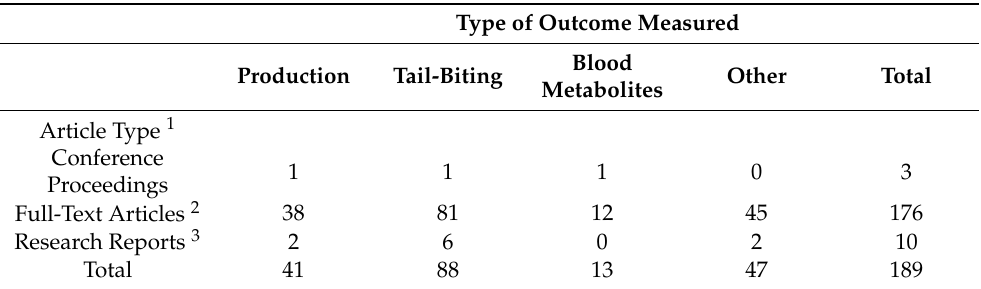
1 Full-text articles included journal articles found in peer-reviewed sources and included an abstract, introduction, methods, results, discussion and reference lists. 2 Research reports included short communications which did not meet full-text article inclusion criteria. Outcomes measured in the studies did not exclusively pertain to TB. The most common outcome measured was TB (88/189; 46.6%); however, production accounted for 41/189 (21.7%) outcomes and other accounted for 46/189 (24.3%) outcomes (Table 3). Reported outcomes for TB included lesion frequencies, tail length or tail damage, as well as condem- nations at slaughter. Lesion frequency and tail length/damage were the most reported TB outcomes, accounting for 59/174 (33.9%) and 77/174 (44.3%) outcomes, respectively (Table 4). Table 3. Article type and outcome variables measured for the literature included in the scoping review.